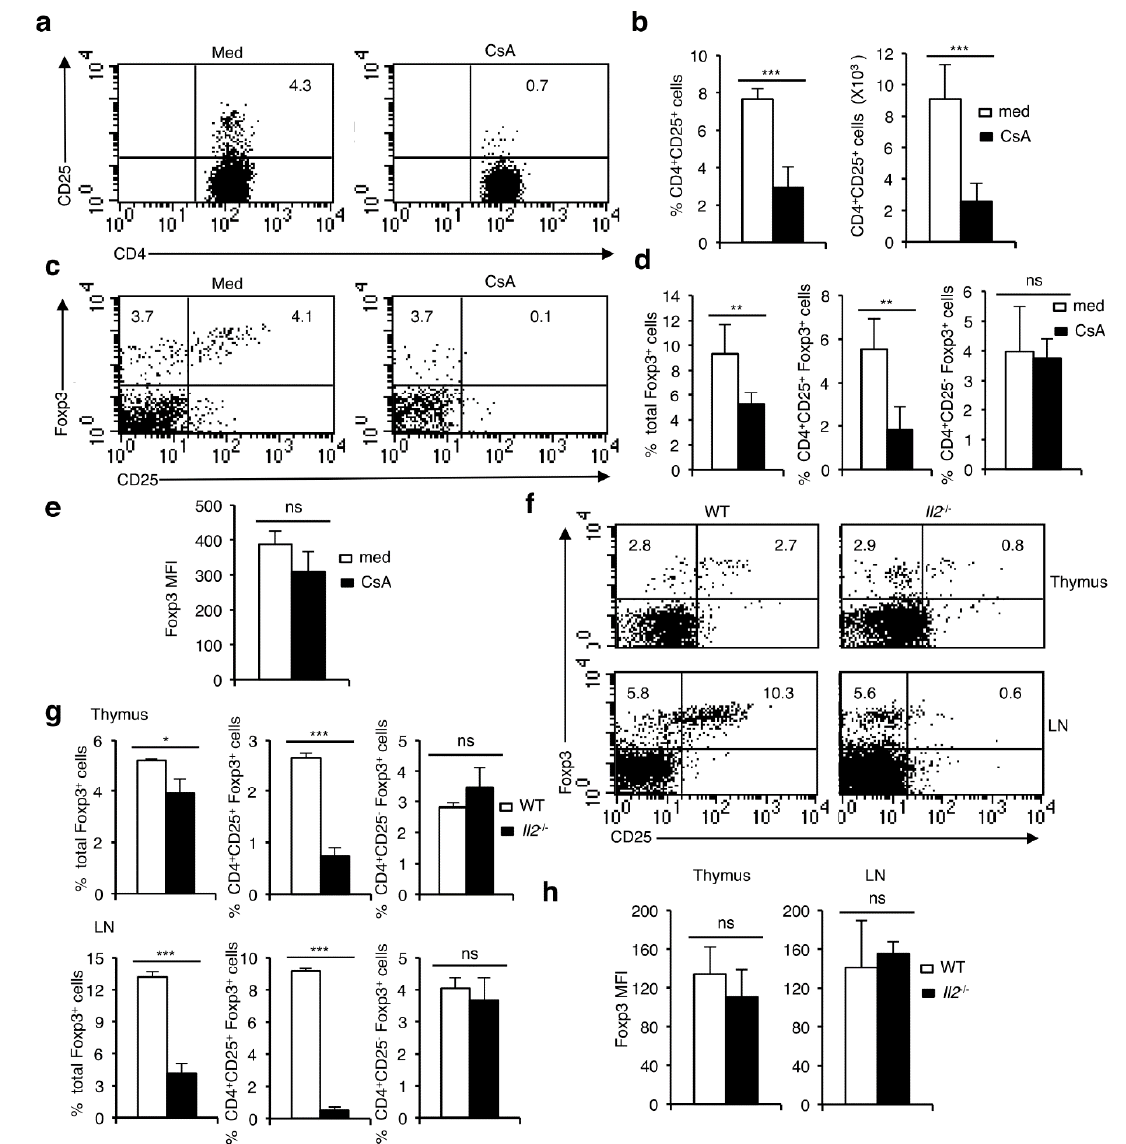
Figure 3. NFAT factors are essential for the maintenance of CD4 + CD25 + Foxp3 + T reg cells. ( a ) Distribution of CD4 + CD25 + T cells in day 3.5 medium or CsA-treated NTOCs from WT mice. ( b ) Quantification of percent distribution and absolute numbers (*** p = 0.0004) of CD4 + CD25 + T cells in day 3.5 NTOCs from WT mice in presence or absence of CsA. ( c ) Flow cytometry showing the distribution of CD25 + Foxp3 + cells gated on CD4 + T cells in day 3.5 NTOCs from WT mice in presence or absence of CsA. ( d ) Quantification of percent distribution of total Foxp3 + (** p = 0.0071), CD25 + Foxp3 + (** p = 0.0015) and CD25 - Foxp3 + (ns = not significant) cells gated on CD4 + T cells in day 3.5 NTOCs from WT mice in presence or absence of CsA. ( e ) Quantification of MFI for Foxp3 expression levels in Foxp3 + cells from day 3.5 NTOCs of WT mice in presence or absence of CsA (ns = not significant). ( f ) Distribution of CD25 - Foxp3 + and CD25 + Foxp3 + cells gated on CD4 + T cells in the thymus, and LNs of Il2 -/- mice compared to WT mice. ( g ) Quantification of percent distribution of total Foxp3 + (* p = 0.0183; thymus and *** p < 0.0001; LN), CD25 + Foxp3 + (*** p < 0.0001; both thymus and LN) and CD25 - Foxp3 + (ns = not significant) cells gated on CD4 + T cells in the thymus, and LNs of Il2 -/- mice compared to WT mice. ( h ) Quantification of MFI for Foxp3 expression levels in Foxp3 + cells from thymus, and LNs of Il2 -/- mice compared to WT mice (ns = not significant). Numbers inside each dot plot represent percent respective populations. Data are representative of three independent experiments, and in ( b , d , e , g , h ) are presented as mean ± s.d., unpaired t